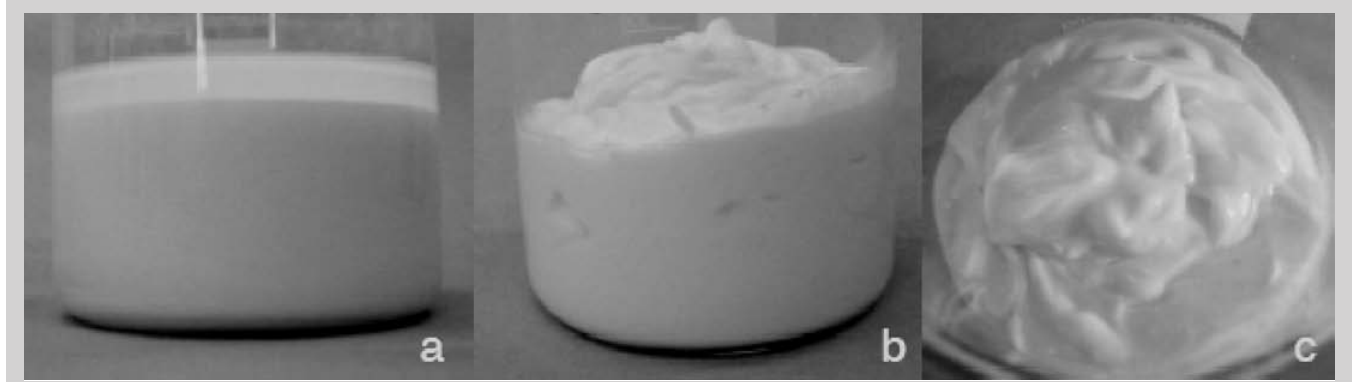
same composition ( F = 56.5 %) and both stirred in Photographs of suspensions with F = 56.5 %, only stirred (160 g mixture, 200 rpm), imaged after one